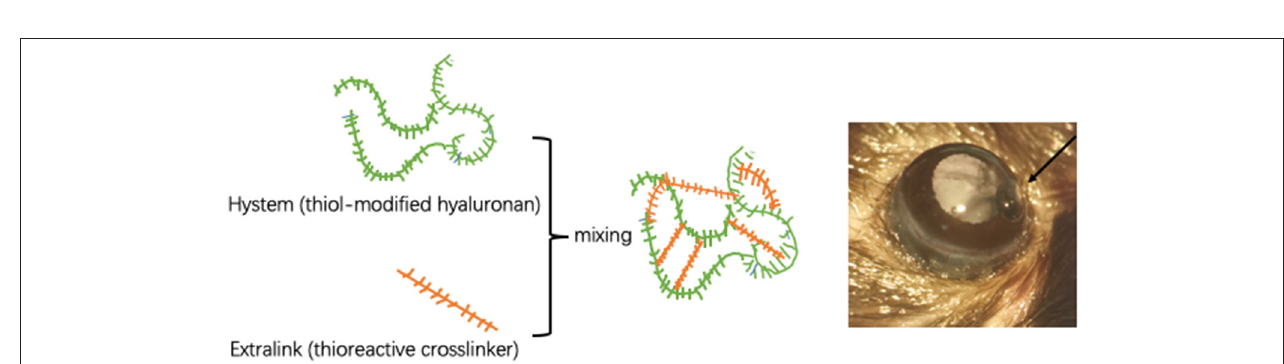
FIGURE 1 | Intracameral injection of cross-linking hydrogel. Schematic diagram of cross-linking hydrogels. The proportion of HyStem and Extralink is 4:1. The hydrogel is injected into the anterior chamber to form solidified gel droplets at the anterior chamber angle.